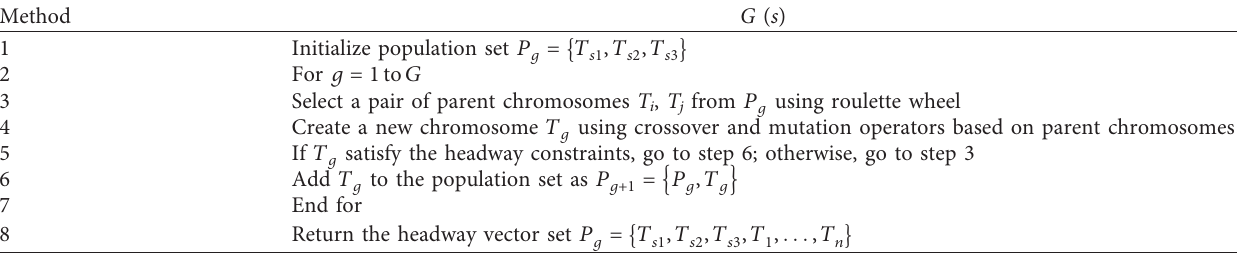
Table 4: Framework and steps of method G ( s